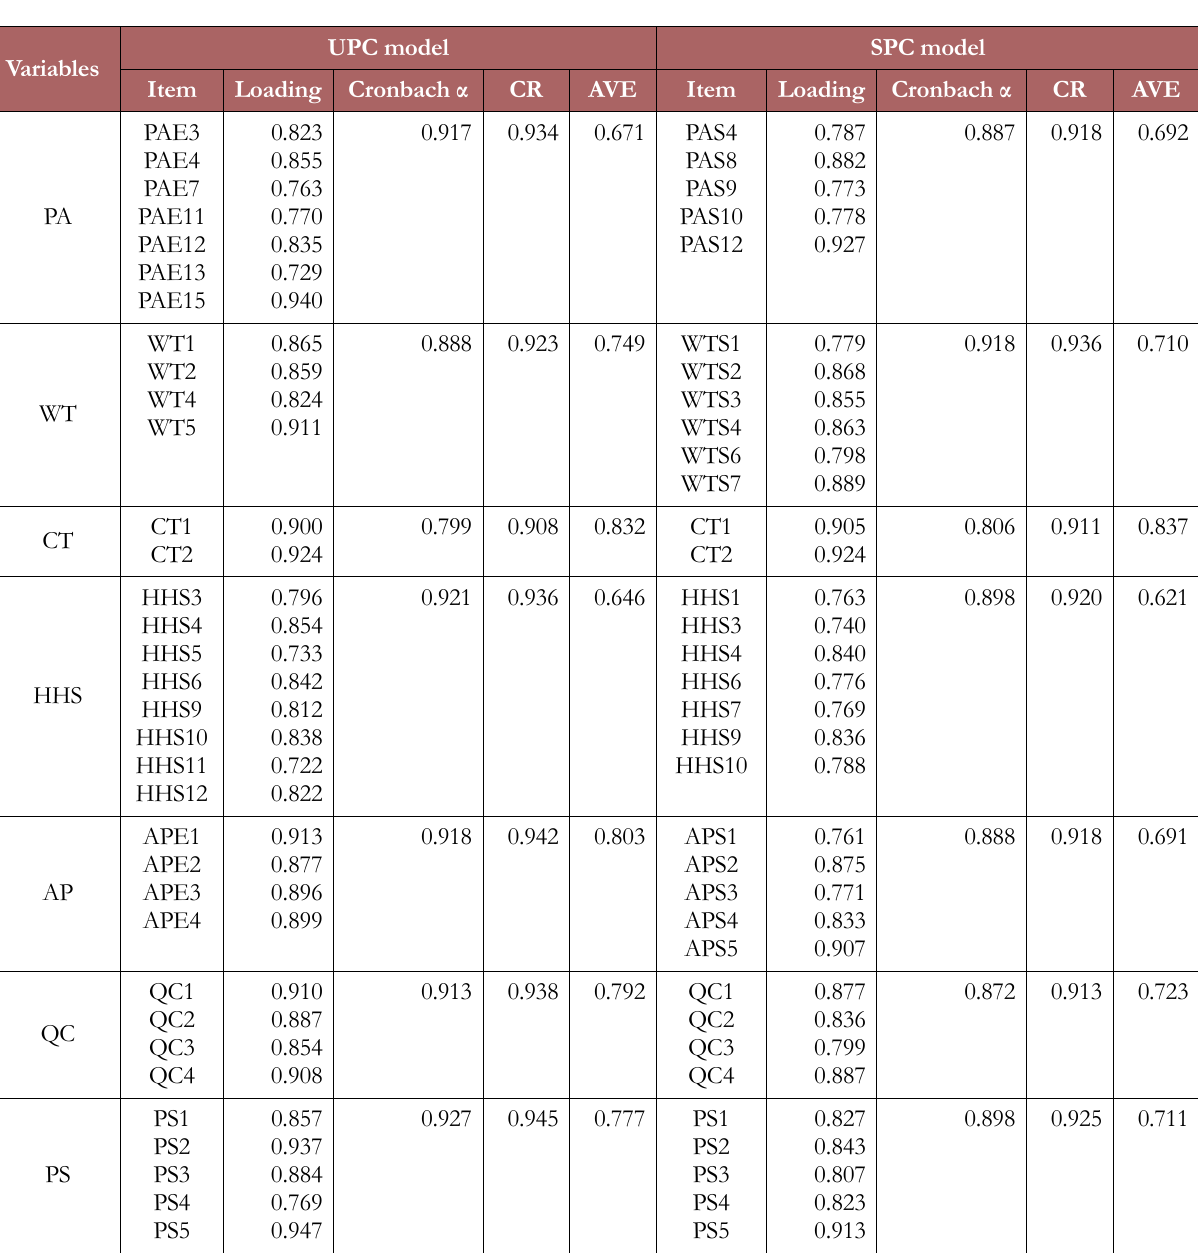
Table 4. Individual item loadings, Cronbach α, Composite reliability, and